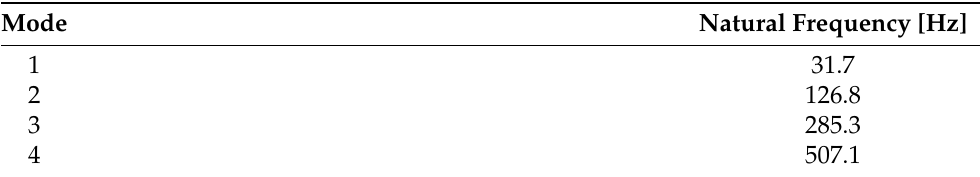
Table 5. Natural frequencies of the Y-rail without the cutting head.